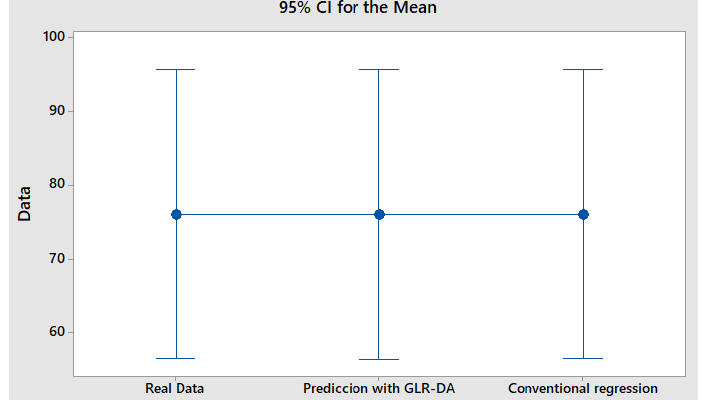
Figure 5. Confidence interval.